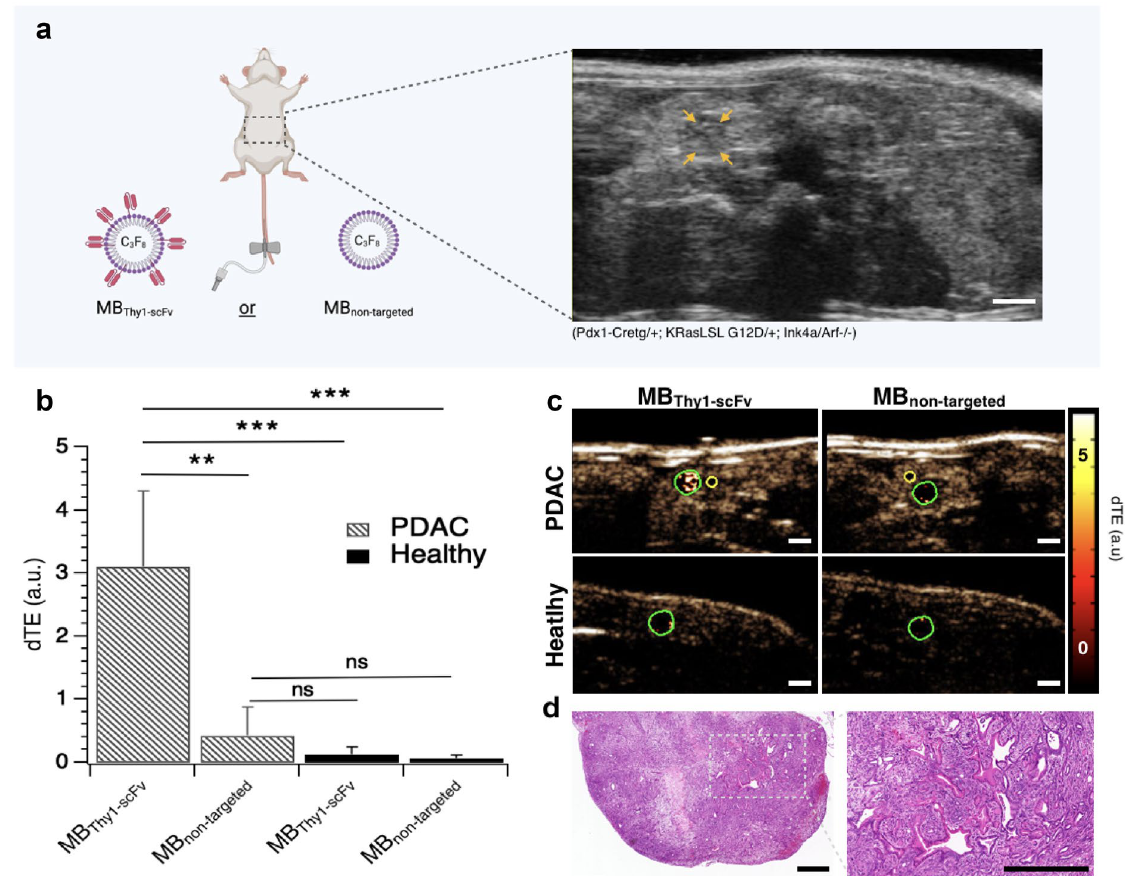
Figure 8. In vivo USMI of Thy1 expression in transgenic mouse model with spontaneous PDAC. ( a ) Schematic illustration of the overall experiment. After localizing the tumor by US B-mode abdominal imaging, MB non-targeted and MB Thy1-scFv xf were successively tested for Thy1 binding in PDAC transgenic mice. Orange arrows delineate a pancreatic tumor. B-mode images were used as references to draw region of interest (ROIs) in differential targeted enhancement (dTE) images presented in ( c ). Scale bar 1 mm; ( b ) Quantitative bar graphs of in vivo dTE using targeted and non-targeted contrast agents in PDAC and healthy mice. ** p < 0.03; *** p < 0.02; ( c ) Representative transverse dTE images showing stronger signal enhancement in PDAC (green ROI) after injection of MB Thy1-scFv , and only low signal following injection of MB non-targeted . Background signal was noted in adjacent normal pancreas (a yellow ROI was drawn to quantify imaging signal in adjacent non-PDAC tissue). Scale bar 1 mm; color coded scale is shown for USMI in arbitrary units (a.u.). ( d ) Corresponding hematoxylin– eosin-stained sample confirmed presence of PDAC in transgenic animals. Scale bar 500